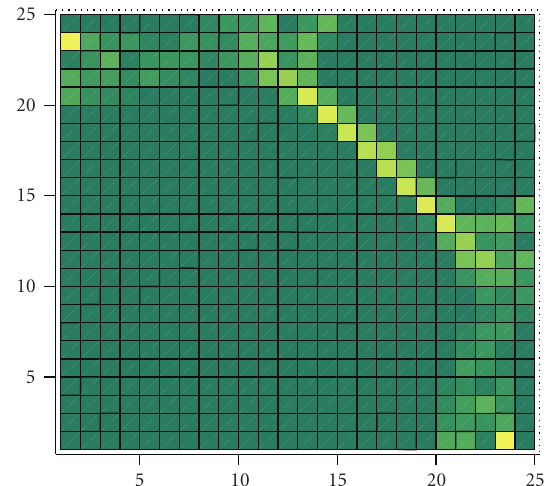
Figure 4: An example of the Fermi surface in the 2D NFE model with fluctuations of V q . The FS is well defined in the diagonal direction, while the fluctuations makes it di ff use in the x and y -